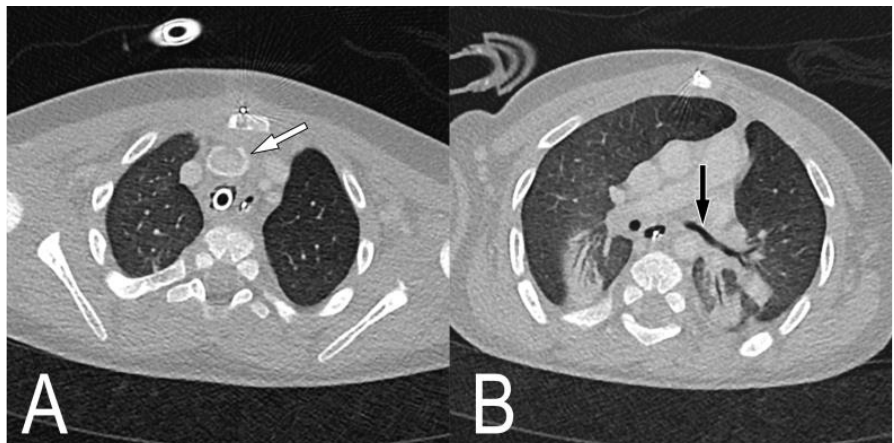
Figure 5. Neck computed tomography images after tracheostomy. ( A ) The white arrow shows that